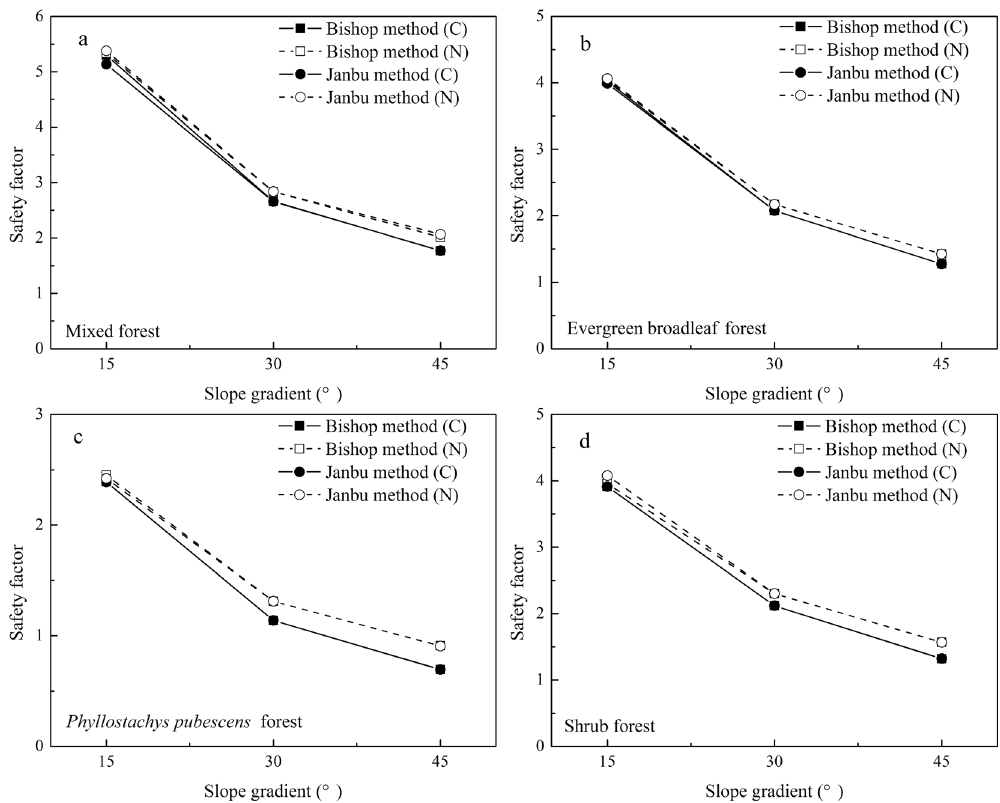
Figure 4. Safety factors in different slope gradients of 4 plant stands. C Indicates calculations that include root effects; N Indicates that root effects were not considered in